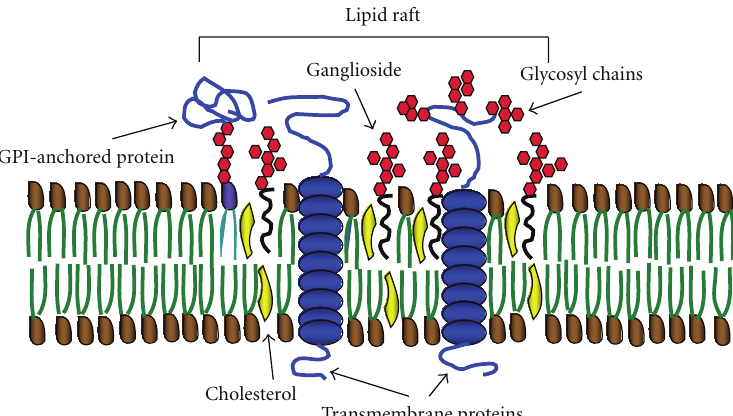
Figure 1: Schematic representation of an LR in the cell membrane, enriched in gangliosides and cholesterol. Glycosylated and non- glycosylated transmembrane proteins and GPI-anchored proteins are also